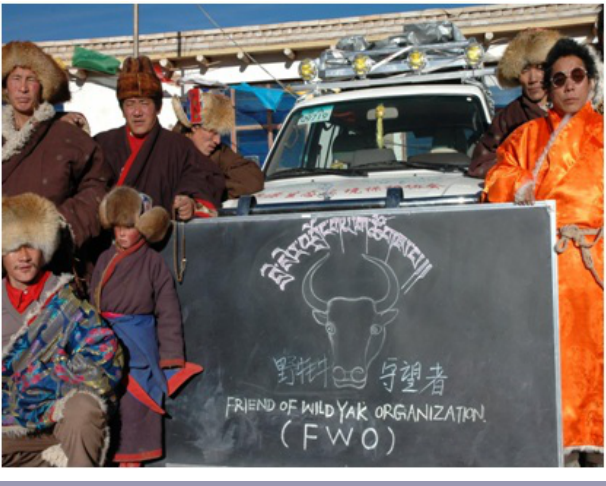
Fig. 6 . A local NGO “Friend of Wild Yak Organization”